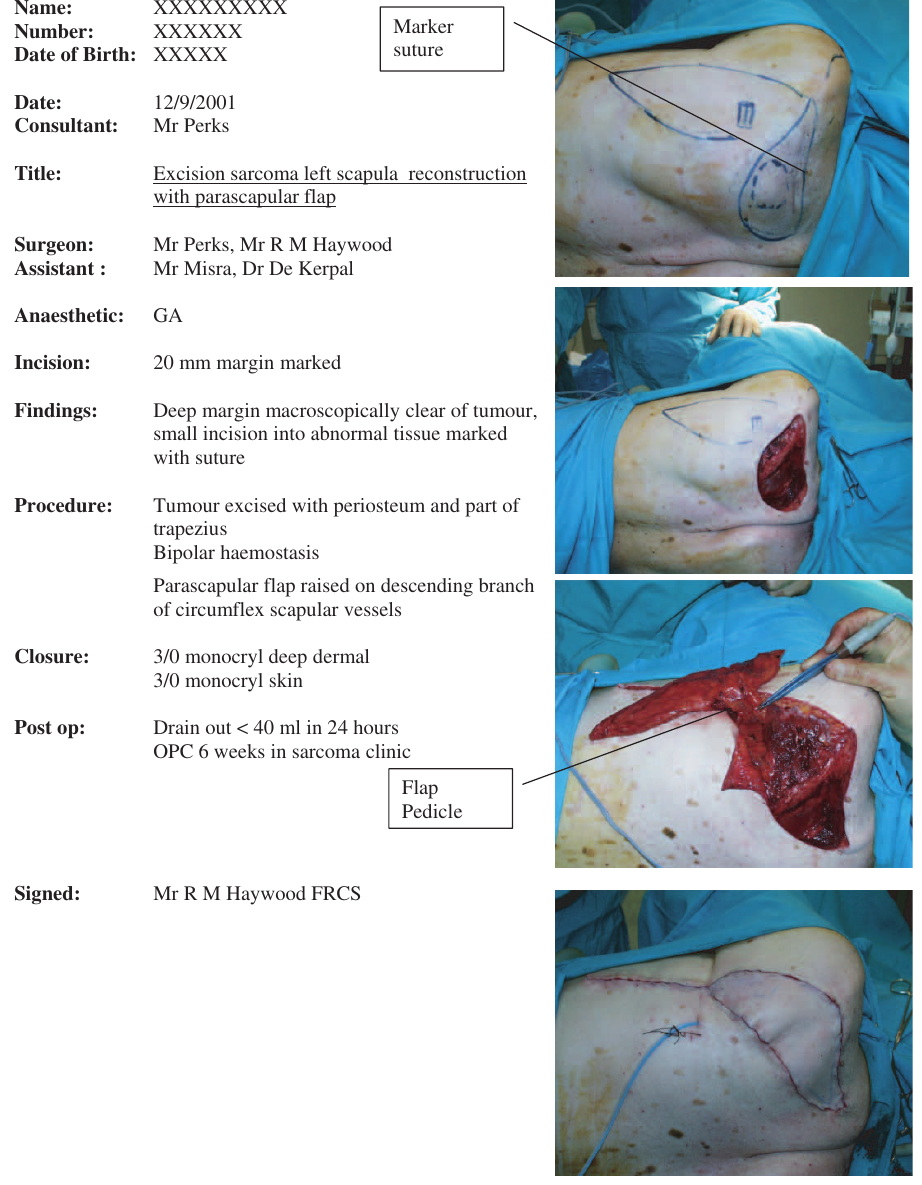
Figure 2. Completed operation